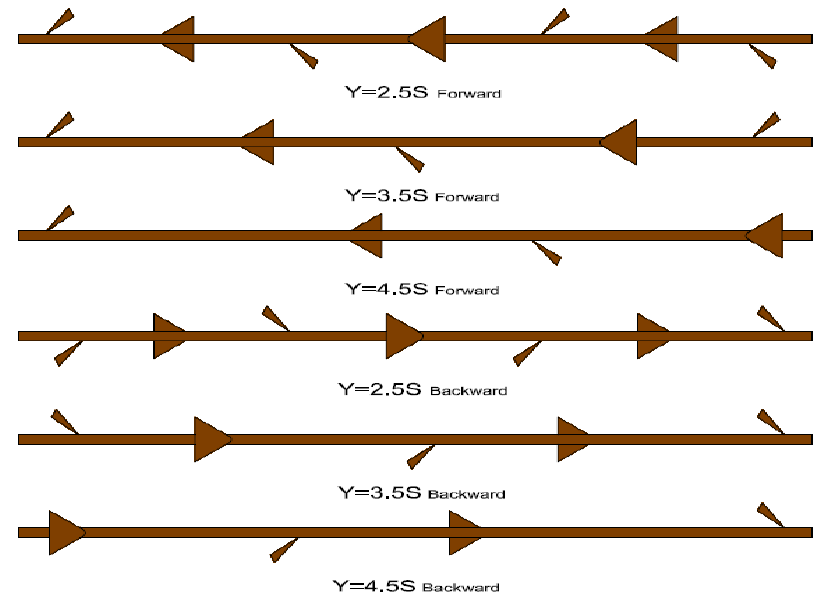
Figure 6. Schematic diagram of the staggered conical strip inserts with forward (FWD) and backward (BWD) arrangements. (BWD)